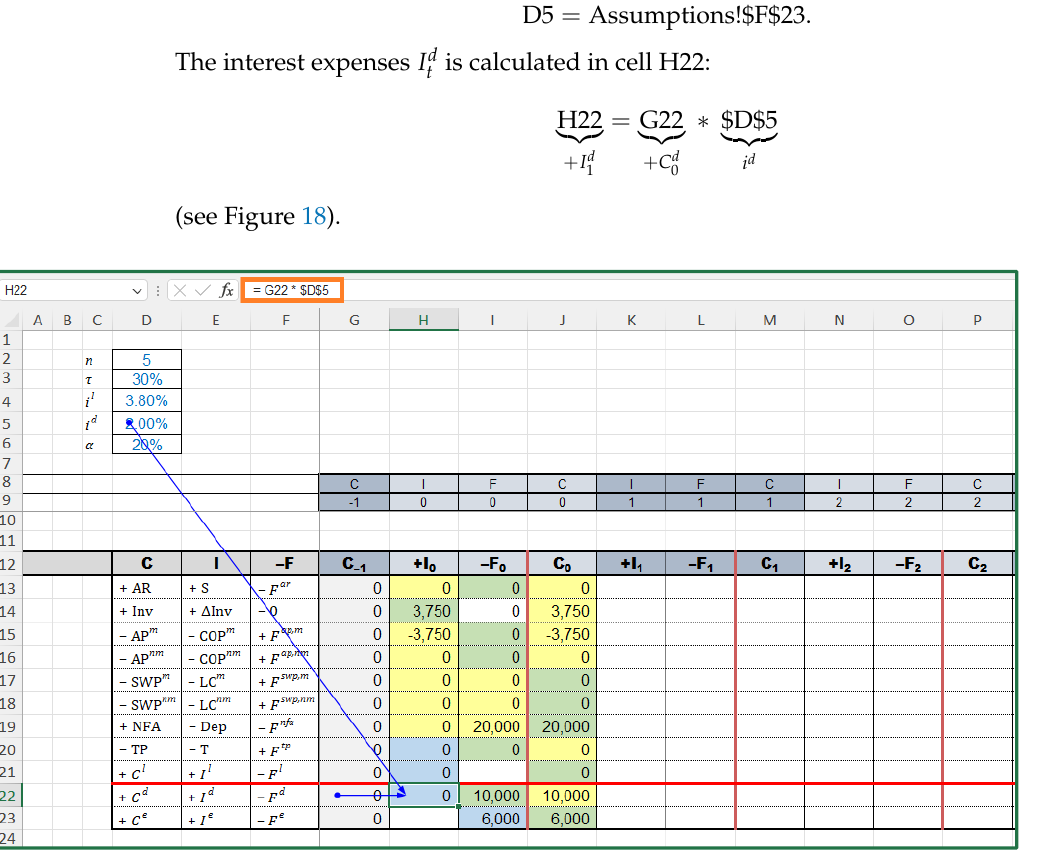
Figure 18. Cell H22 contains the interest expenses (“SplitScreenStrip” sheet). (The cells whose values are provided in “PreCalc” are in yellow, the cells whose values are calculated with the law of motion are in green and the cells whose values are calculated via suitable formulas are in blue.)